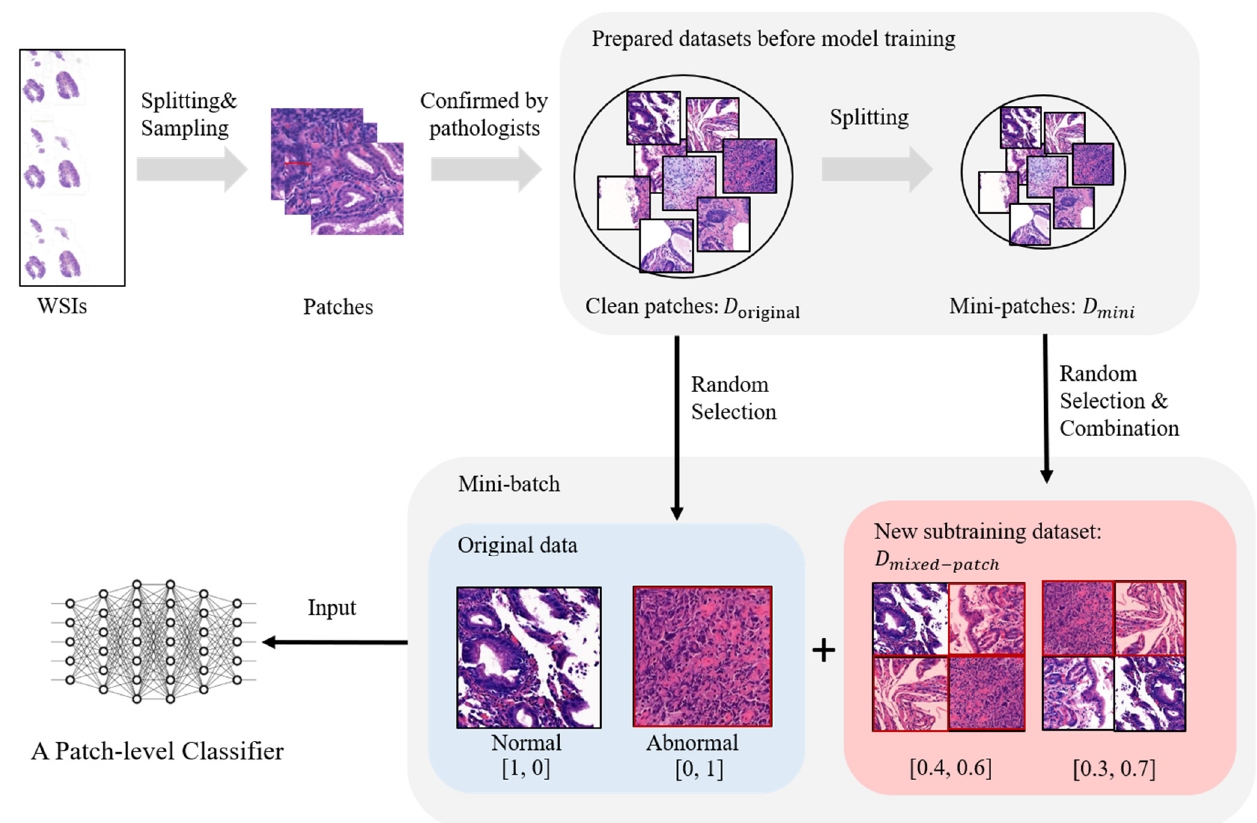
Figure 2. The overall process of the proposed method. In the existing methods, the patch-level classifier is trained using a CNN model and a cleaned patch dataset, D original , which pathologists previously confirmed. The proposed method, MixPatch, additionally uses a new subtraining dataset, which consists of image x mixed and label y mixed . x mixed is built by combining randomly selected images from the minipatch dataset. y mixed is defined according to the ratio of abnormal mini-patches. In the figure, a minibatch is a randomly built mix of samples from D original and samples from D mixed − patch